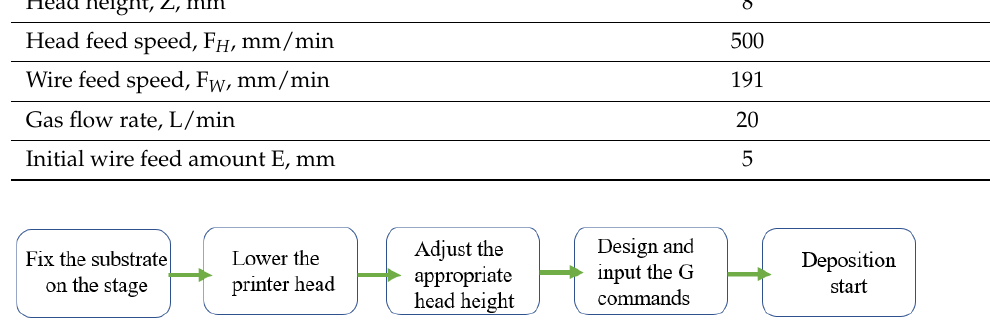
Figure 2. The preparation flow chart before printing. Table 1. Composition of the Ti6Al4V wire.